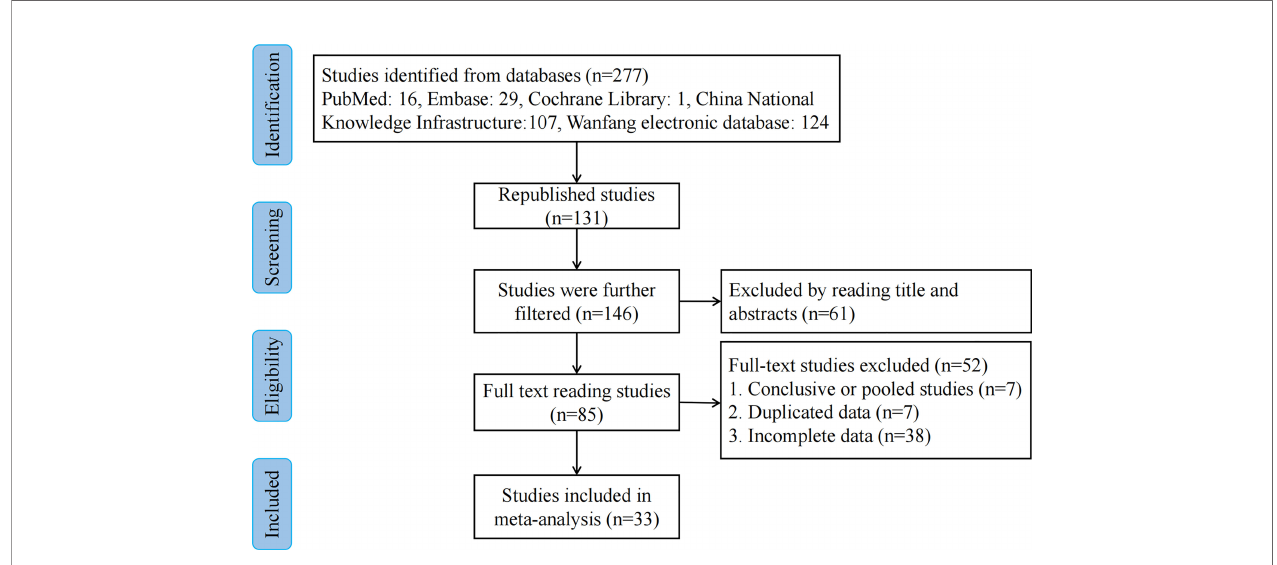
FIGURE 1 | Flowchart of the study selection